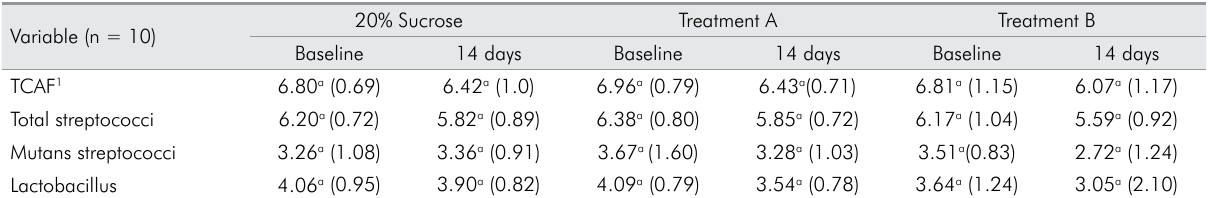
Table 3. Mean and standard deviation (SD) of microorganisms in saliva (log CFU/mL) at baseline and after 14 days (in situ study). Variable (n = 10)